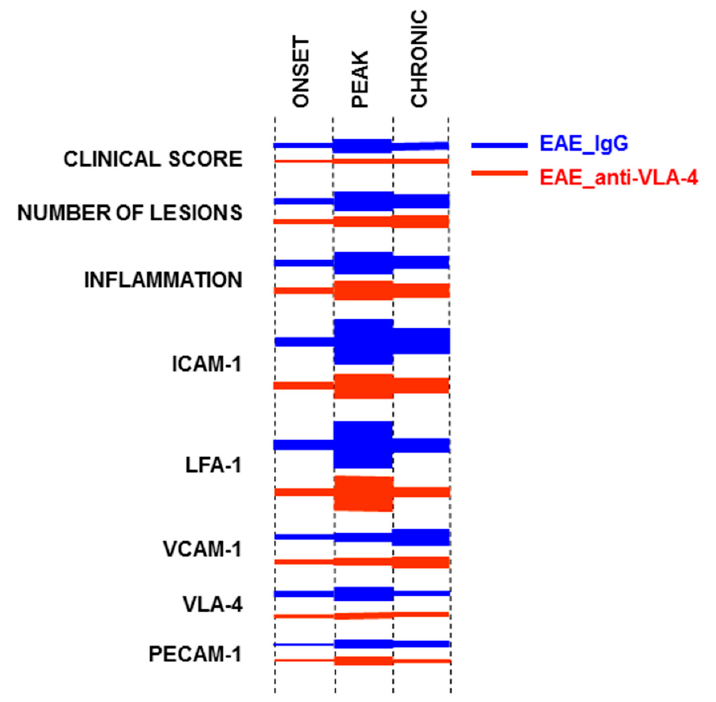
Figure 6. Graphic summary of intensity/expression levels and changes in the studied EAE parameters in the successive phases of the disease. Thickness of segments represents quantitated levels.